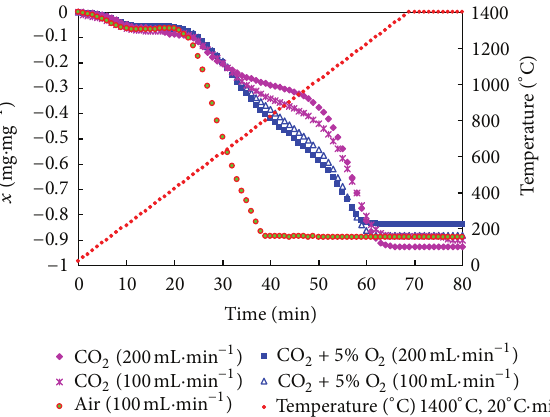
Figure 5: TG curves of different gas flow rates and O 2 concentra- tions in flow gas.